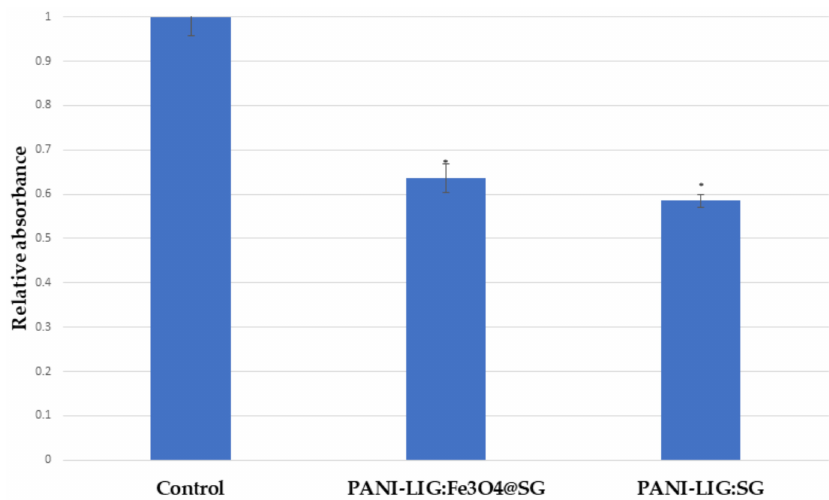
Figure 9. MG-63 cells metabolic activity for control (Ti), PANI-LIG:SG, and PANI-LIG:Fe3O4@SG coatings (data is expressed as relative to the Ti control; results are expressed as mean ± SD ( n = 3) and presented as fold of control; student’s t -test p < 0.05